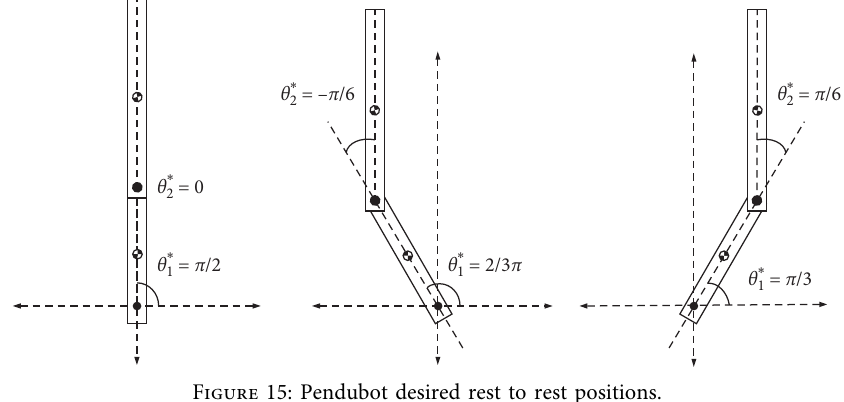
Figure 15: Pendubot desired rest to rest positions.